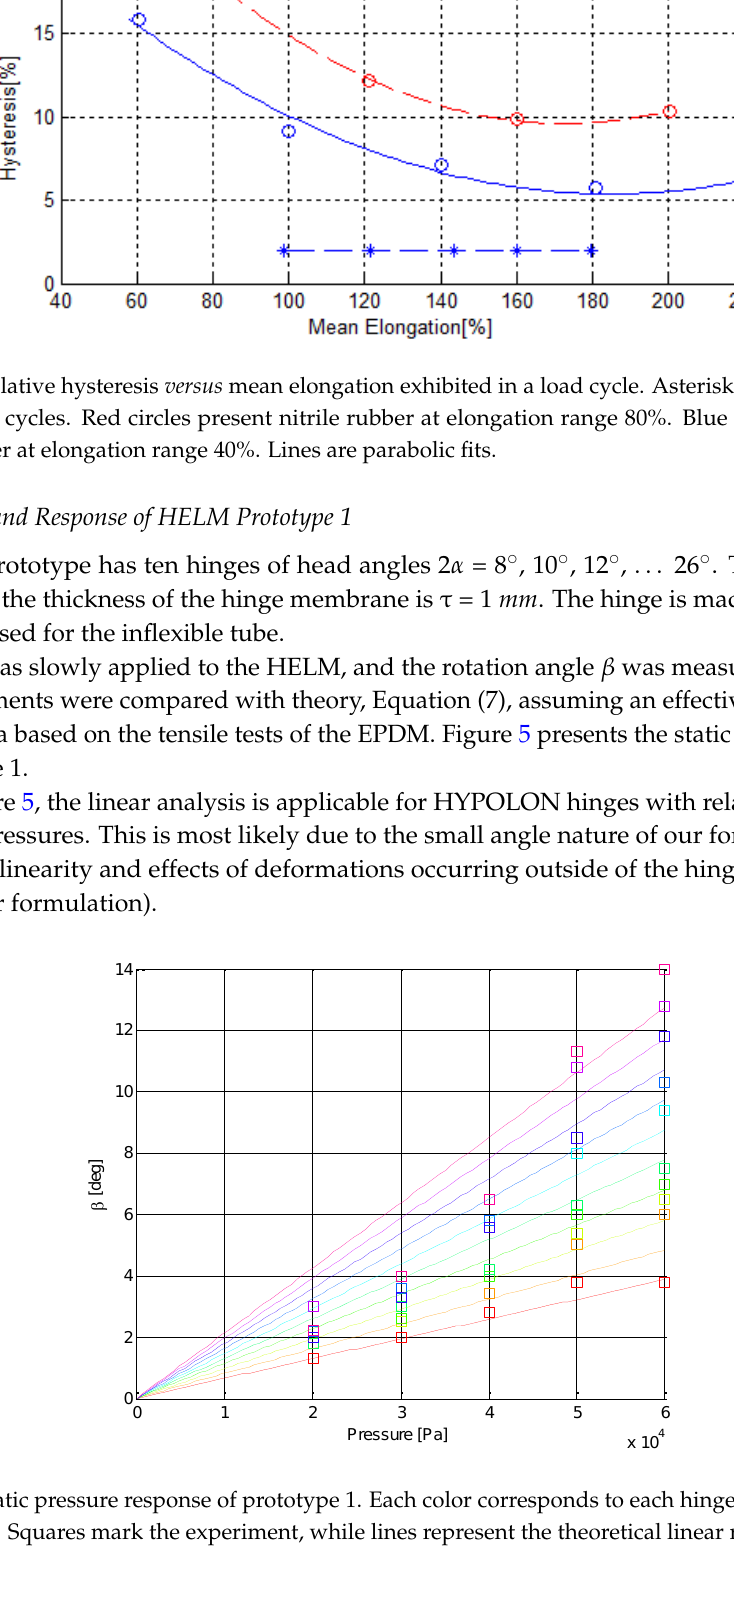
Figure 5. Static pressure response of prototype 1. Each color corresponds to each hinge (of a specified head angle). Squares mark the experiment, while lines represent the theoretical linear response.